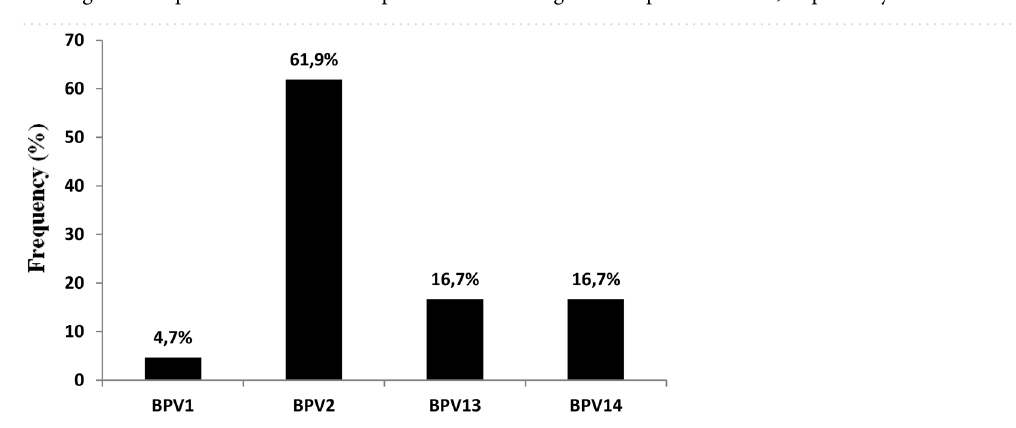
Figure 2. Percentages of single BPV DNA detection found in the 42 positive